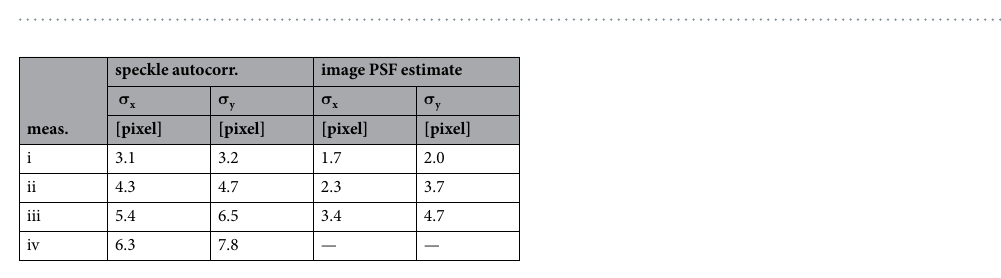
Figure 4. Reconstruction of a shadow of a part of USAF 1951 in Rhodamine 6G emission. ( A ) A reconstructed image for 4 different mean speckle sizes ( M = 1500 measurements, 96 × 96 pixel image, M / N = 16%); ( B ) The mean autocorrelation of all speckle patterns; ( C ) Cross-section of three vertical target lines (averaged values from lines 50–65) for the 4 reconstructed images; ( D ) The same scene (USAF target shadow, speckle mean width σ x = 3.1 pixel, σ y = 3.2 pixel) reconstructed from an increasing number of datapoints, M / N = 1%, 2%, 4%, 9%, and 17%, respectively.